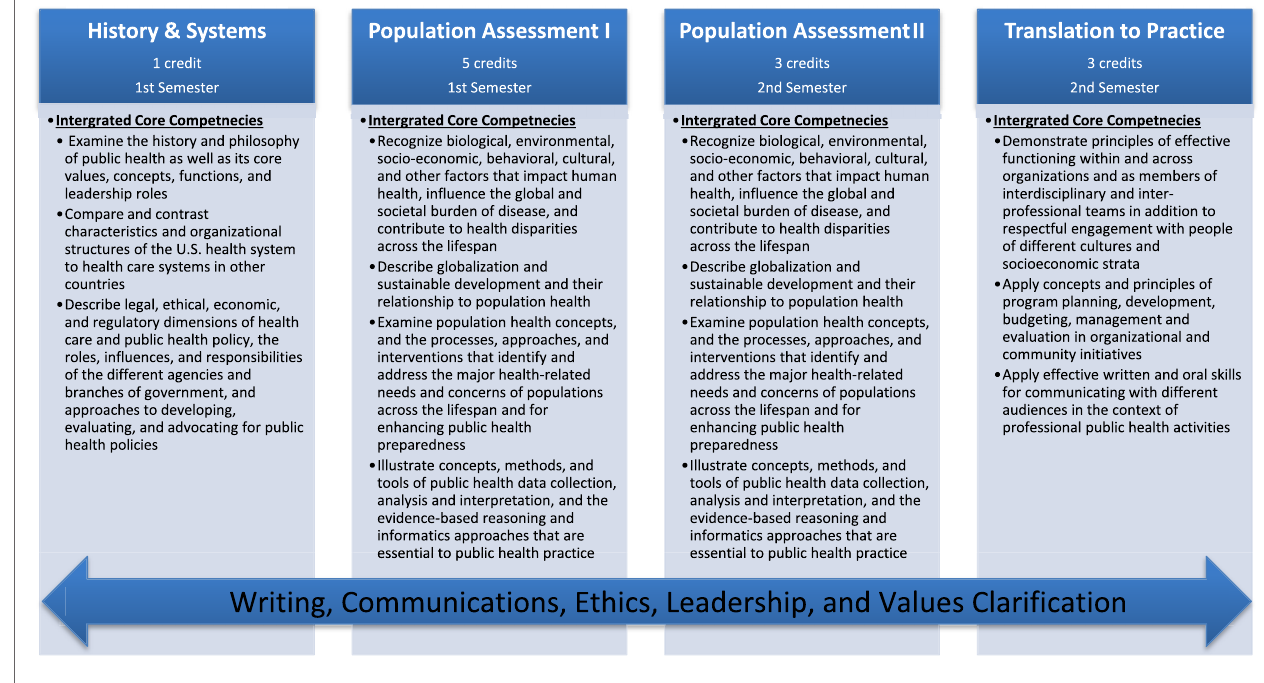
Figure 1 | Transformed MPH course structure and associated competencies.